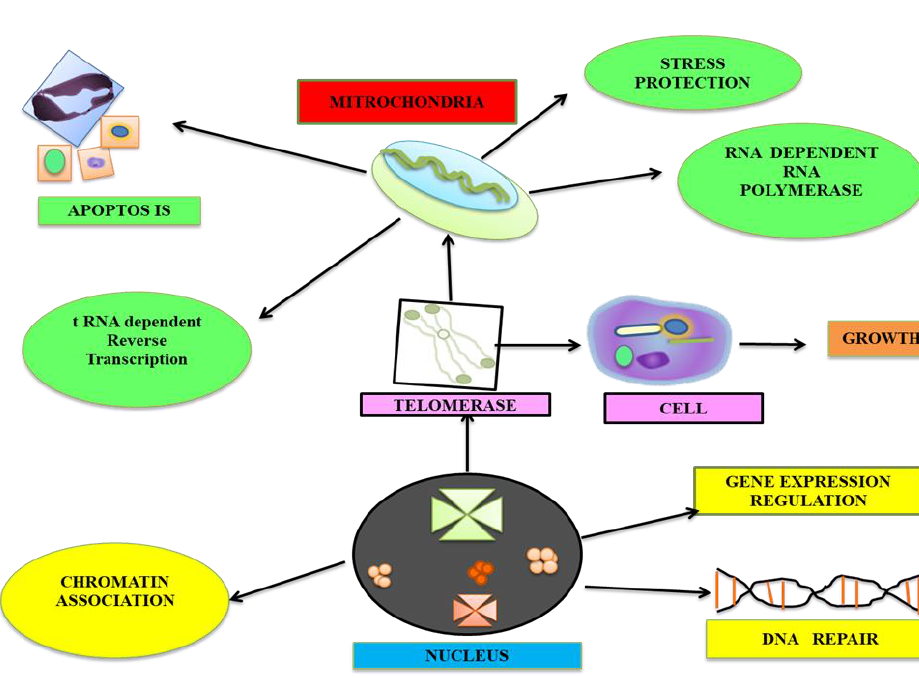
Figure 9. Telomerase enzyme and cell proliferation.